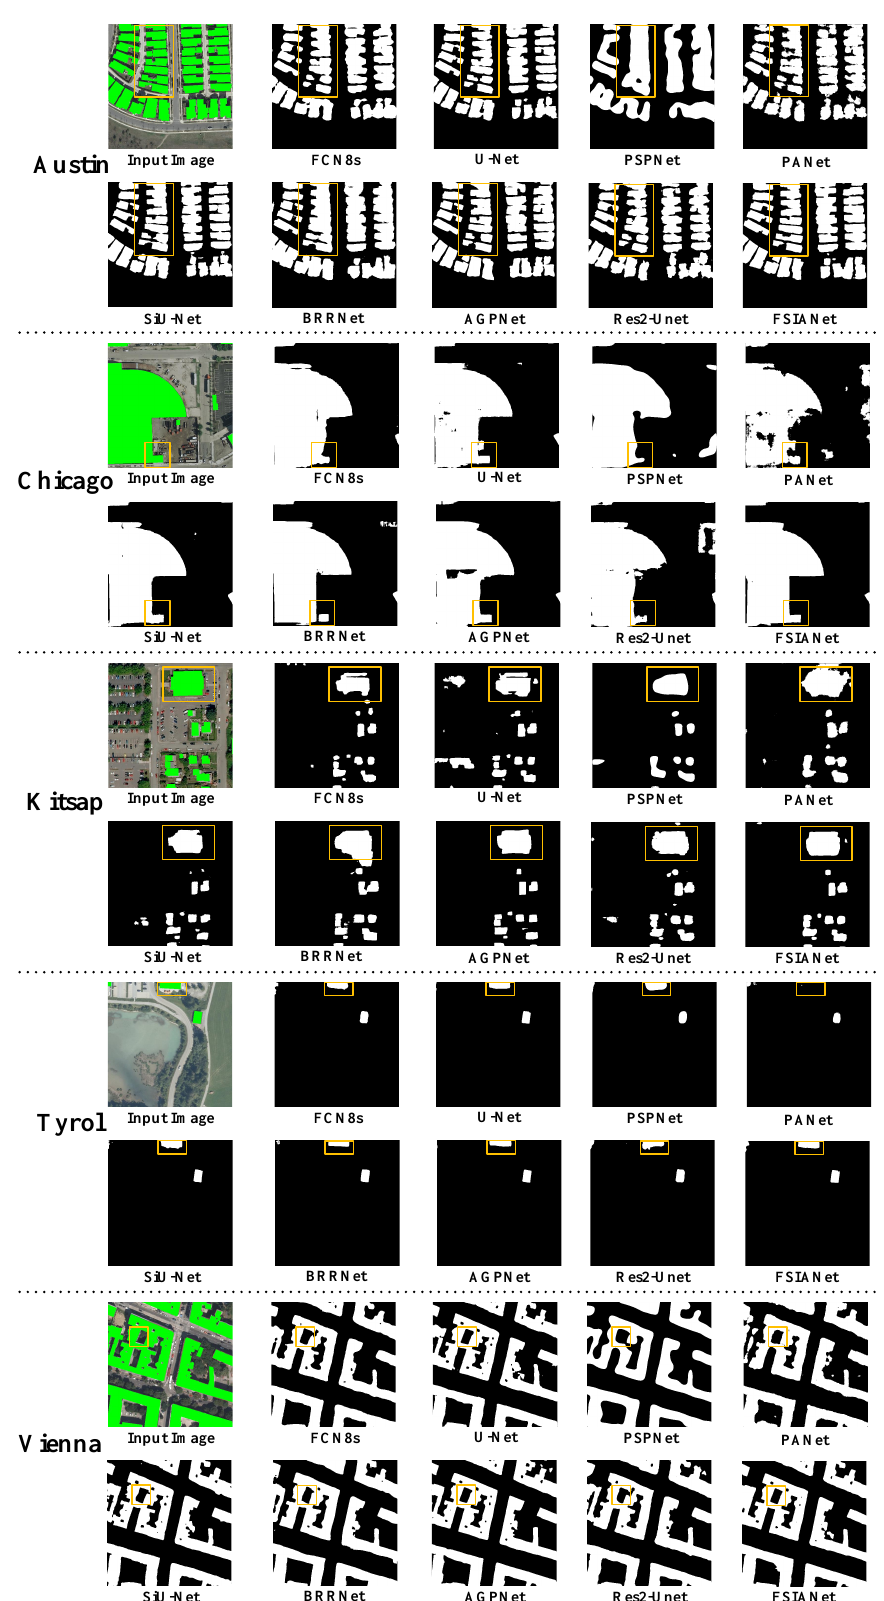
Figure 6. The visualization results of the proposed FSIANet and other comparison methods on the Inria Aerial Image